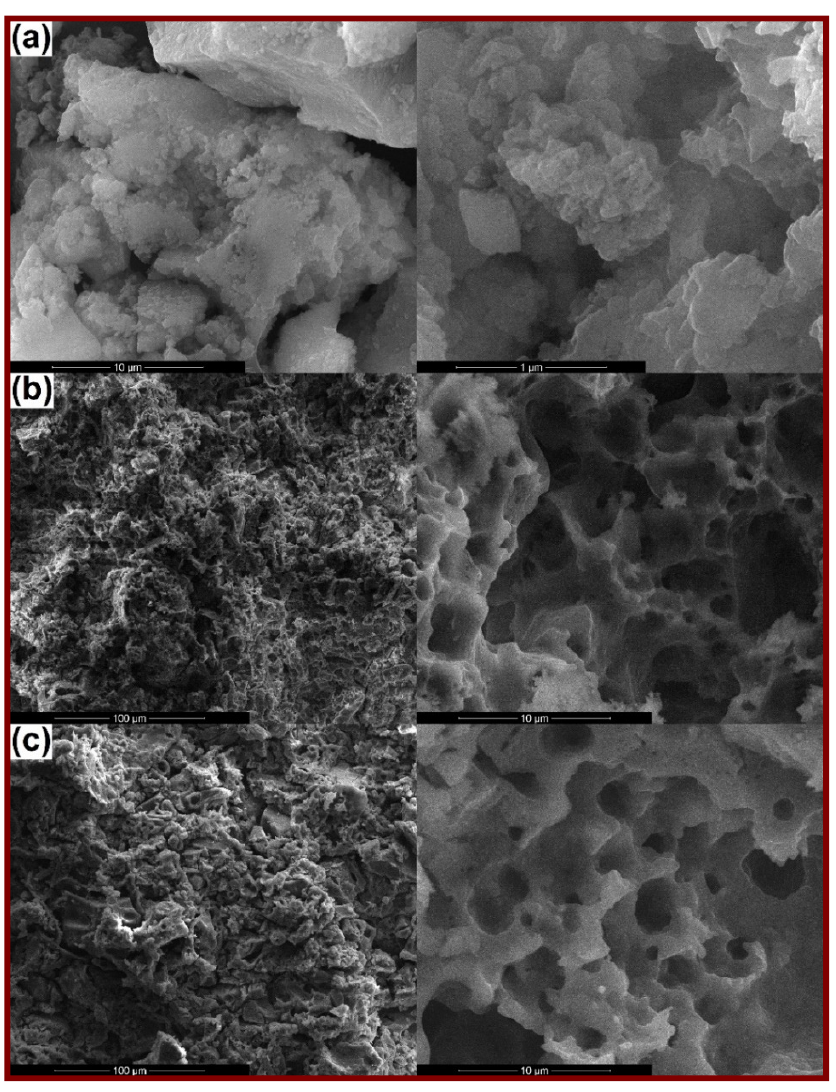
Figure 4. SEM images of: ( a ) Sr calcined powder (10,000× and 100,000×), ( b ) Sr-1000 sintered scaffold (1,000× and 10,000×) and ( c ) Sr-1200 sintered scaffold (1,000× and 10,000×).